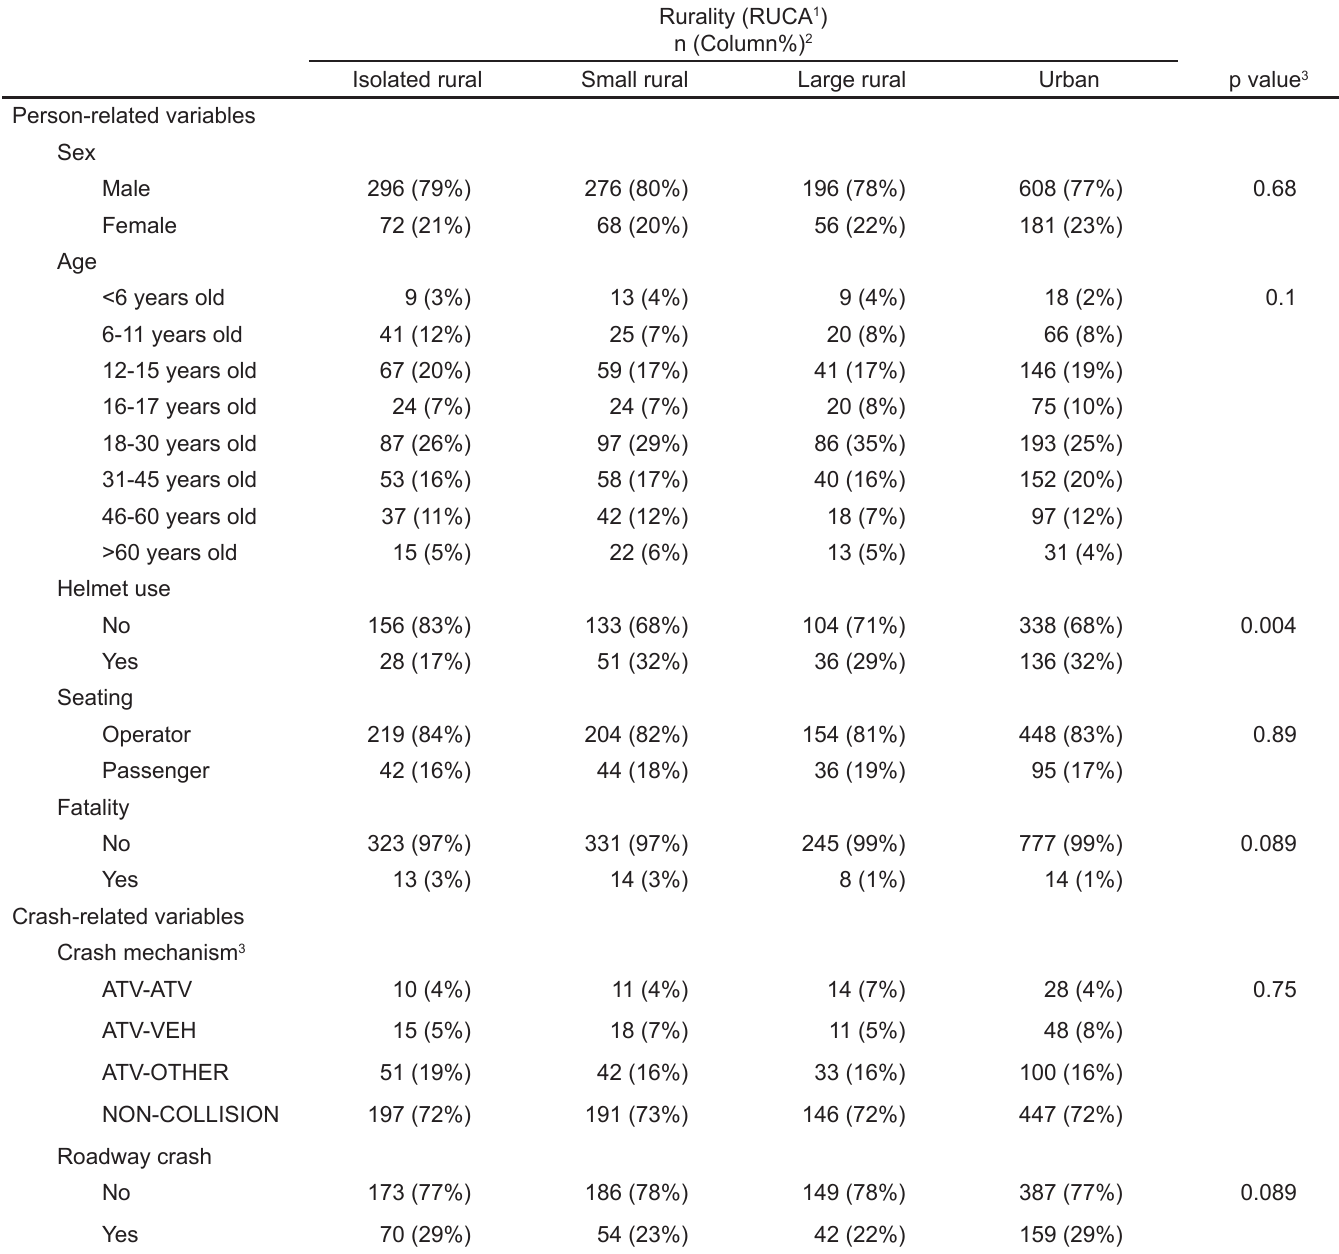
Table 2. Comparison of victim and crash characteristics as a function of rurality for ATV crashes in the Iowa Off-Road Vehicle Crash and Injury Database from January 1, 2002, through December 31,